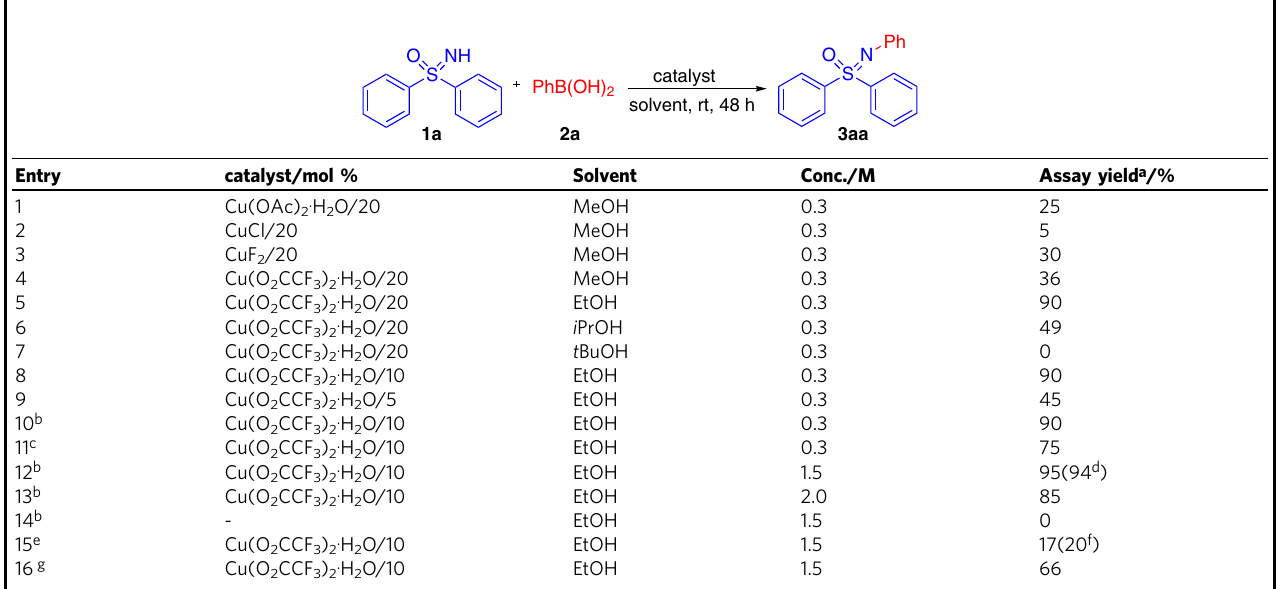
Table 1 Optimization of copper-catalyzed photoredox Chan-Lam coupling of 1a with 2a.